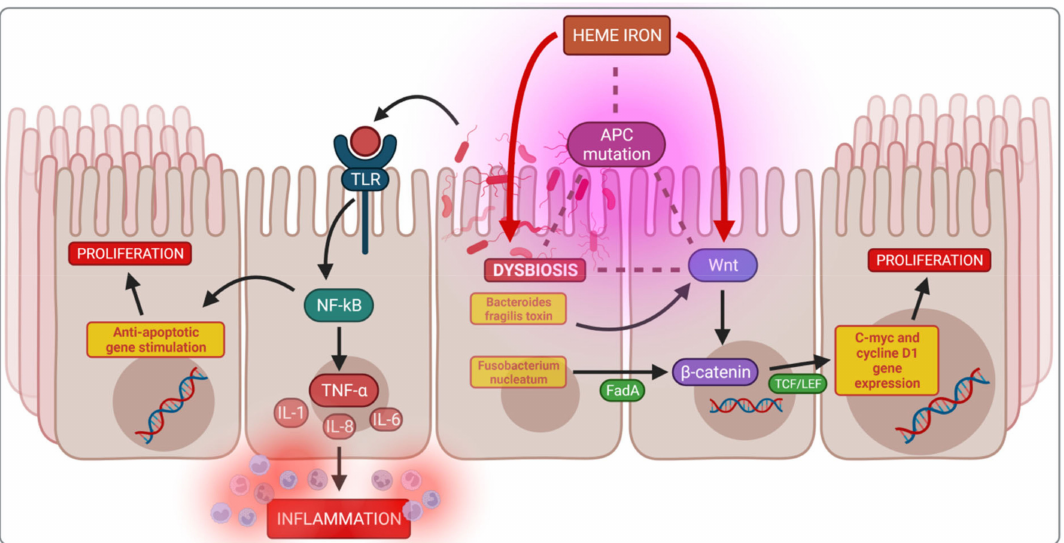
Figure 5. Mechanisms of heme iron induction of colorectal carcinogenesis. APC—adenomatous polyposis coli gene; C-myc, c-Myc–oncogenes; FadA—Fusobacterium nucleatum adhesin; IL-1— interleukin 1; IL-6—interleukin 6; IL-8—interleukin 8; NF-k β —nuclear factor kappa-light-chain- enhancer of activated B cells; TCF/LEF—T-cell factor/lymphoid enhancer factor family; TLR—Toll- like receptor; TNF- α —tumor necrosis factor α ; Wnt—Wnt signaling